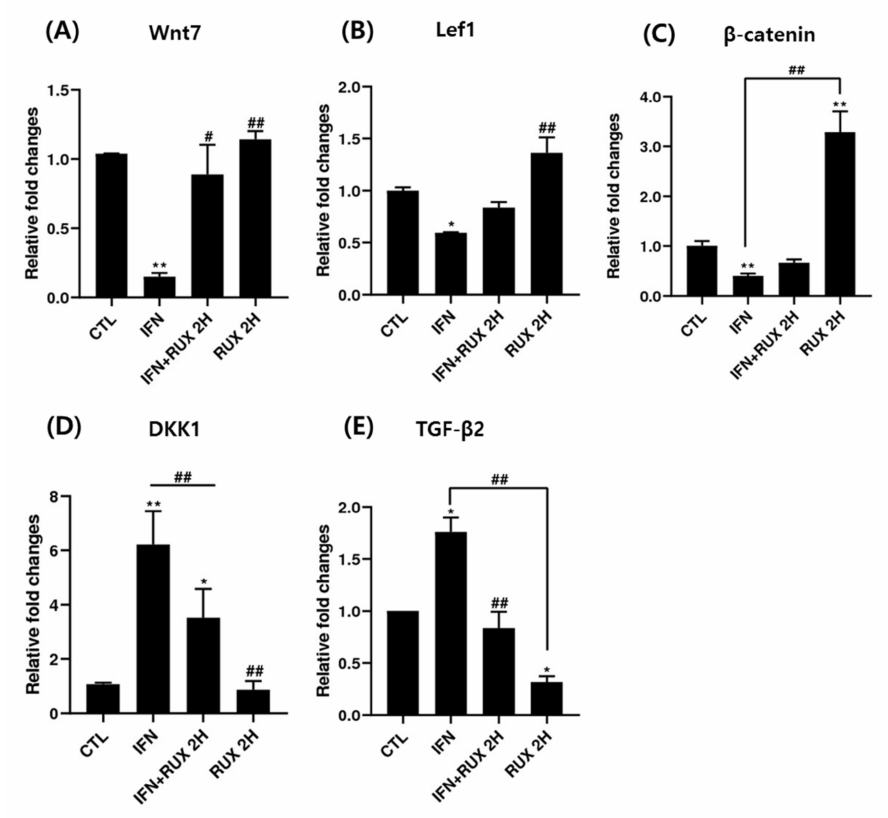
Figure 4. The e ff ects of ruxolitinib treatment on molecules related to the Wnt / β -catenin signaling pathway. The mRNA expression of ( A ) Wnt7 , ( B ) Lef1 , ( C ) β -catenin , ( D ) DKK1 , and ( E ) TGF- β